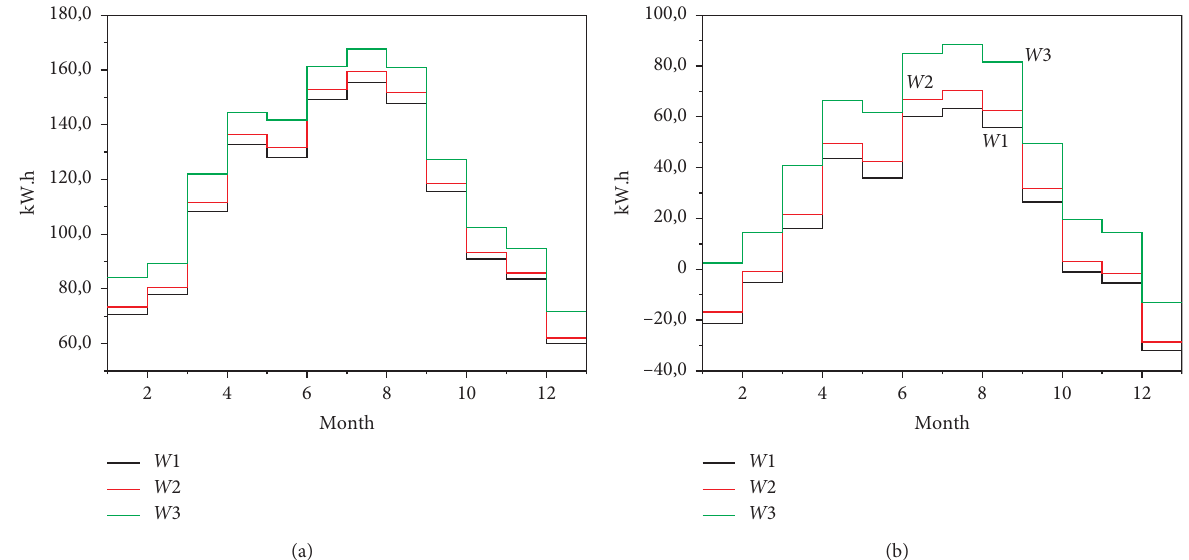
Figure 13: Annual saved energy by the three PV chains models (classical LVAC on-grid (syst1), conventional LVDC (syst2), proposed LVDC (syst3)) for each month of the year in Jeddah city (for (a):one office and (b): two offices’ load).